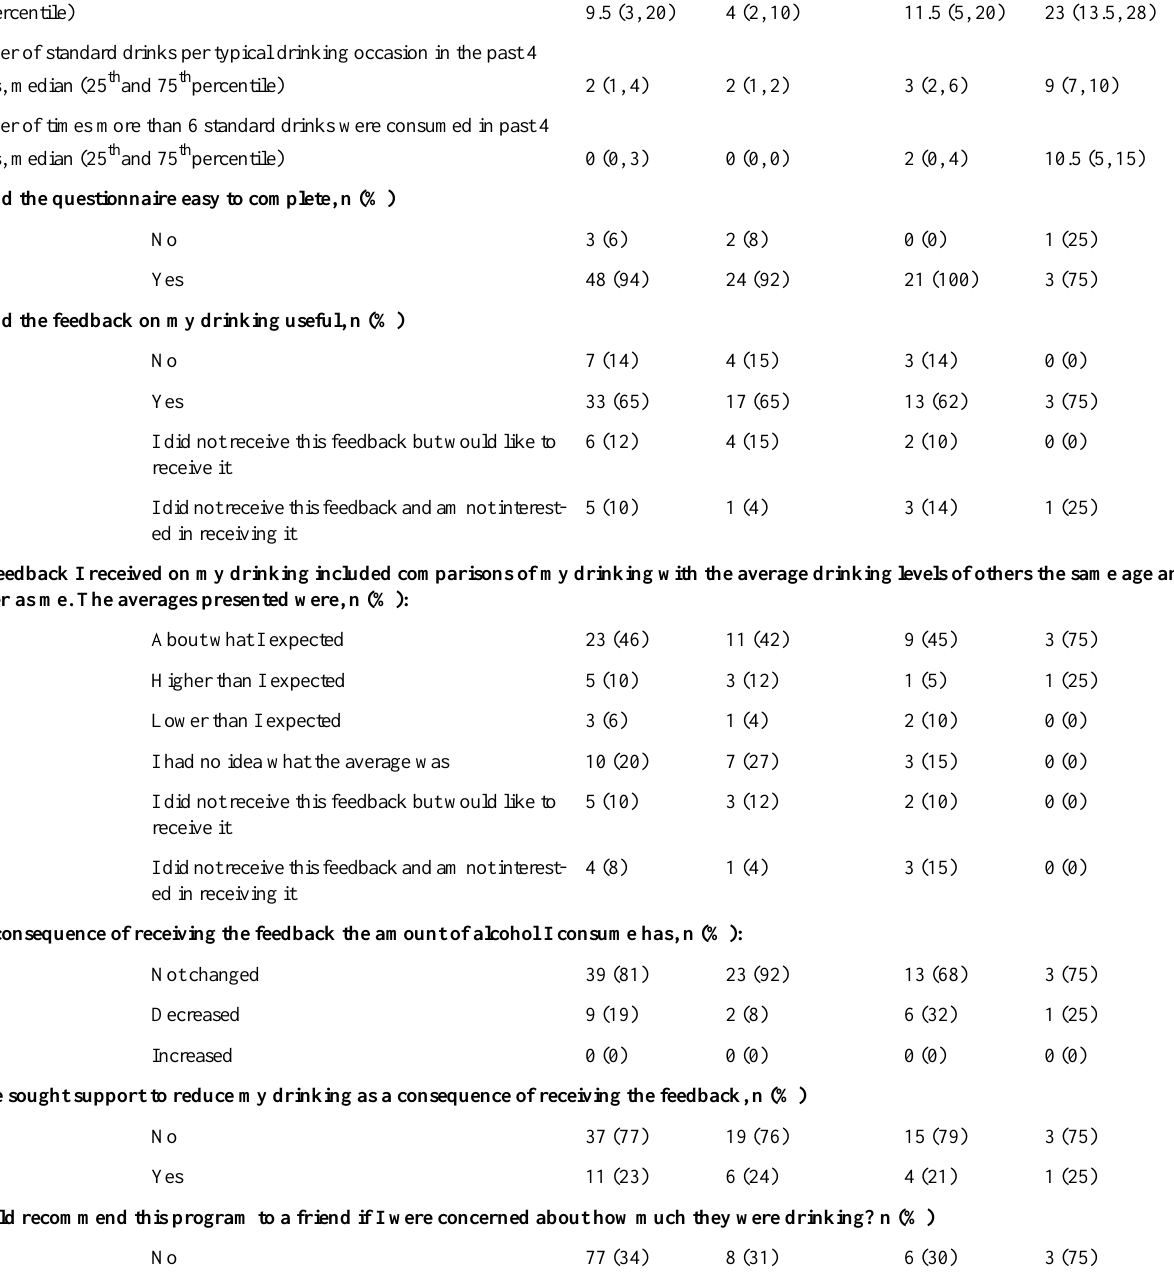
AUDIT-C ScoreAll